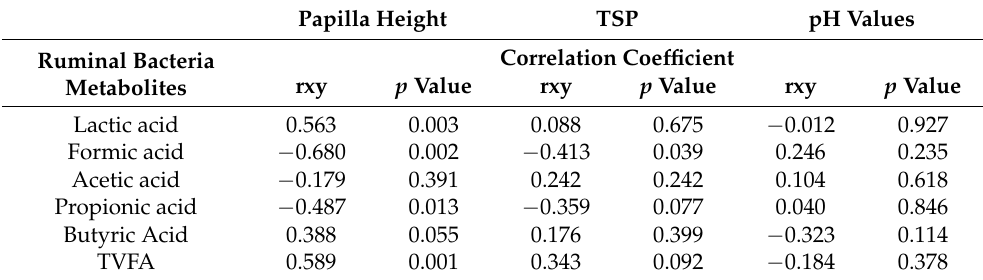
Table 7. Pearson Correlation between volatile fatty acid and pH values or rumen